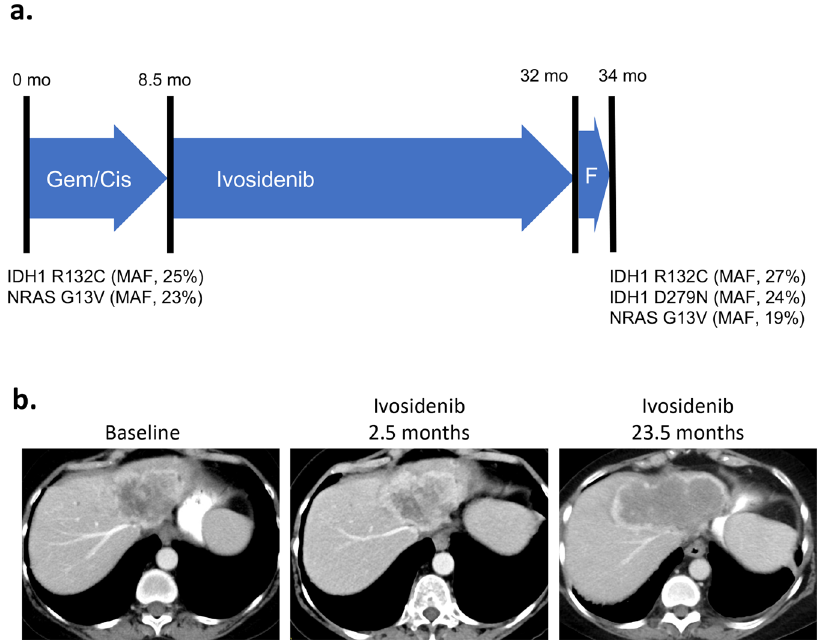
Fig. 2 Treatment course for IDH1 -mutated intrahepatic cholangiocarcinoma — Patient #2. a Time of therapy is shown in months (mo). Notable somatic mutations, with mutation allele frequencies (MAF), found by sequencing of a tumor biopsy (liver metastasis) are indicated below the timeline. Gemcitabine/cisplatin (Gem/Cis) and FOLFOX (F). b CT scans demonstrating the patient ’ s cancer at baseline (1 week before starting ivosidenib) and after 2.5 and 23.5 months of ivosidenib